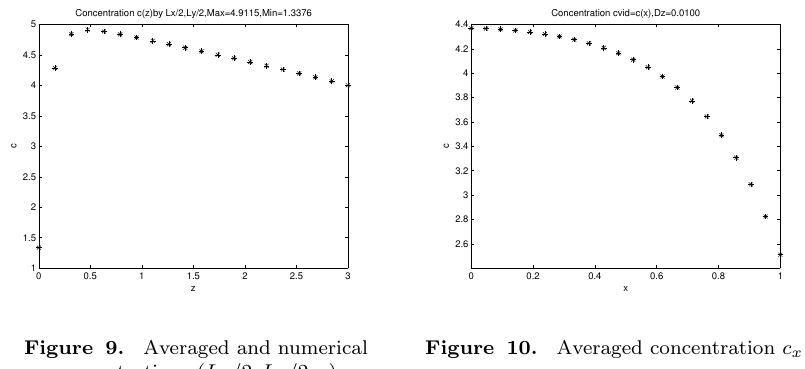
Figure 9. Averaged and numerical concentration c ( L x / 2 ,L y / 2 ,z )